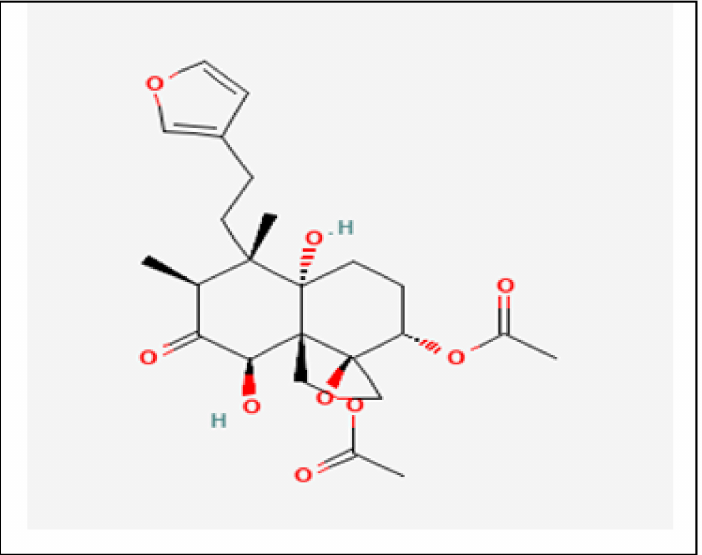
Figure 2. Structure of teucrolivin B isolated from T. oliverium